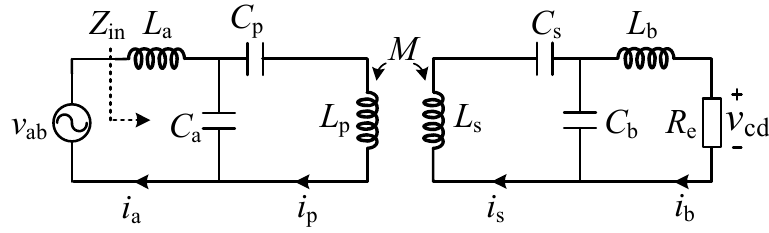
Figure 2. Schematic diagram of double-sided LCC WPT system. analysis of the circuit while maintaining accuracy. The DC voltage and inverter portion can be replaced by an AC voltage source v ab , and the rectifier together with the load resistance can be represented by an equivalent load R e . A fundamental harmonic model can be established, as shown in Figure 3. The equivalent series resistance (ESR) is neglected.